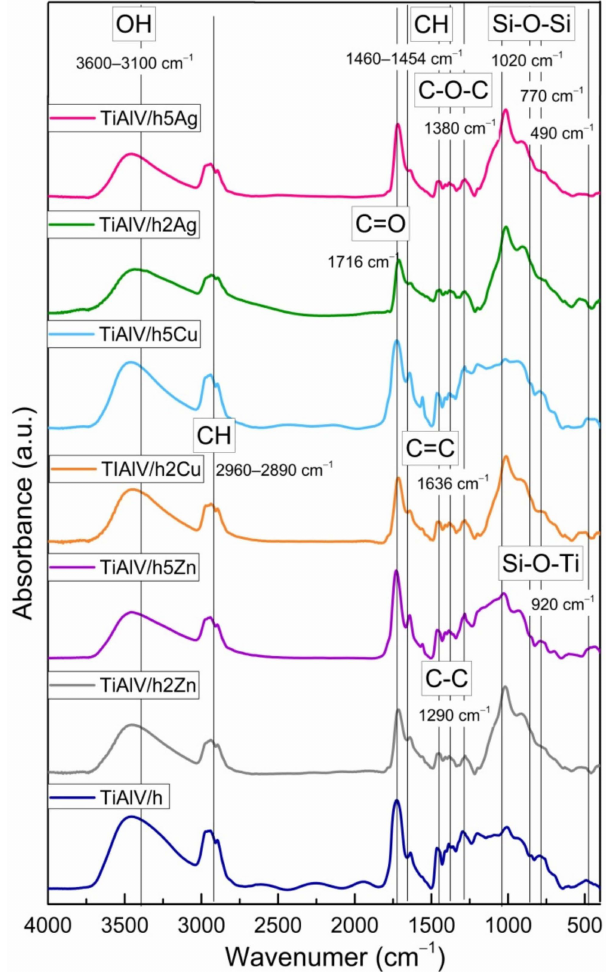
Figure 6. FTIR spectra of titanium alloy (TiAlV)-covered sol–gel hybrid layer containing 2 and 5 mol % silver, copper, and zinc